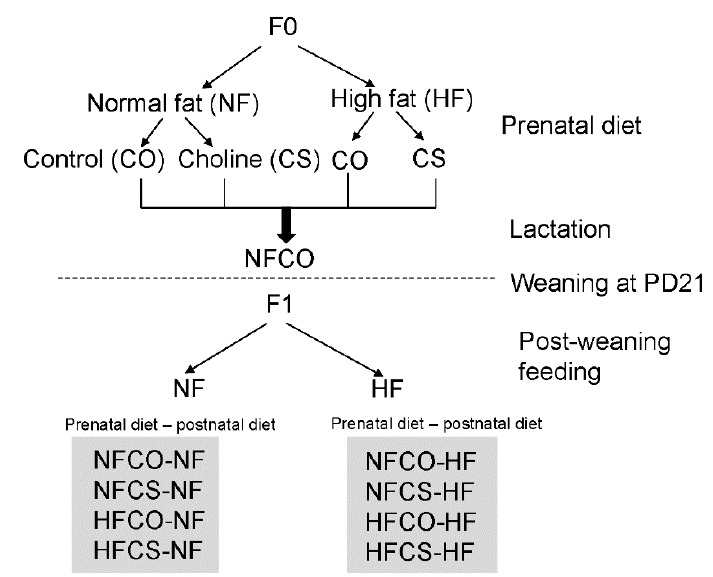
Figure 1. Study design. F0: mouse dams; F1: mouse offspring; NF: normal fat (10%kcal); HF: high fat (60% kcal); CO: untreated control without choline; CS: choline supplemented; PD: postnatal day.